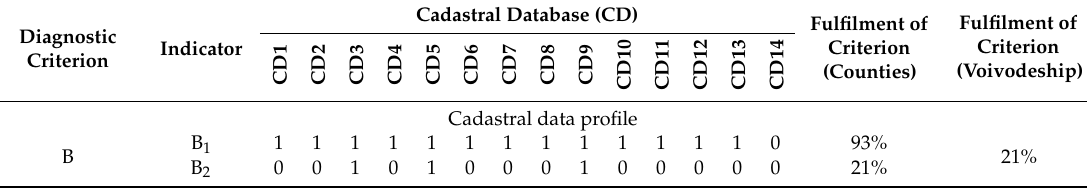
Table 10. Evaluation of Cadastral Databases Based on Criterion B.